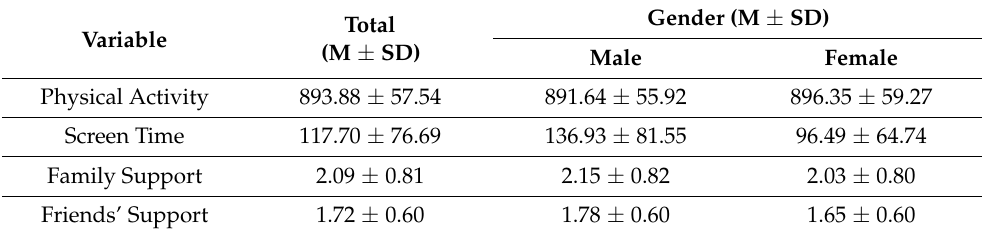
Table 1. Descriptive characteristics of the variables.